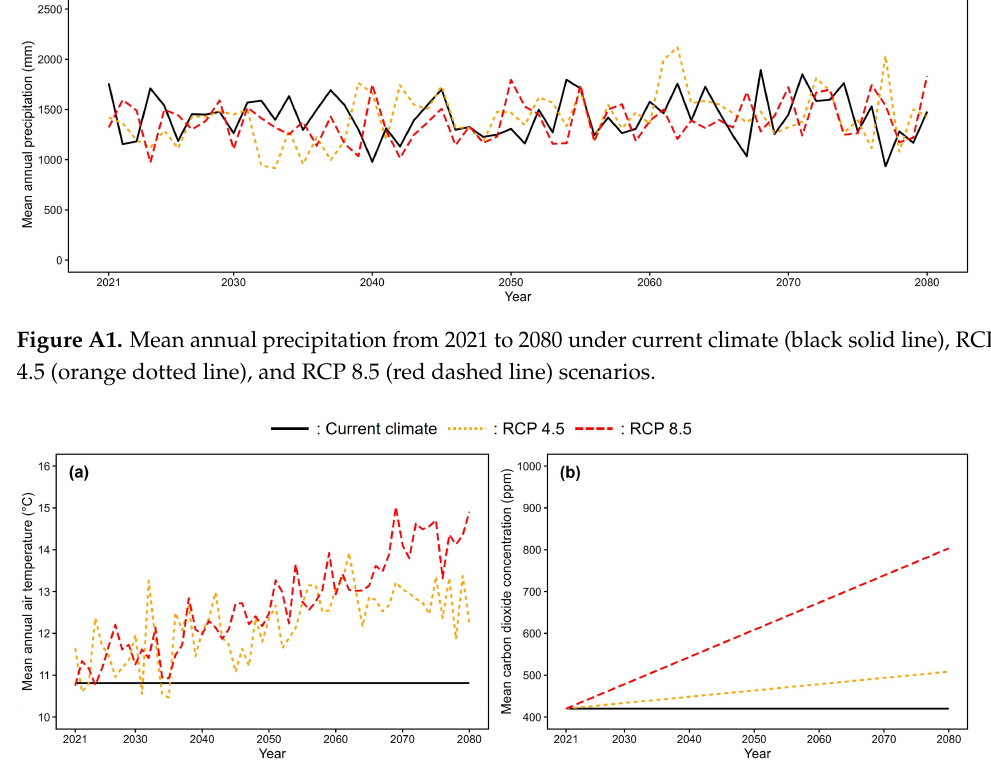
Figure A2. Mean ( a ) annual air temperature and ( b ) CO 2 concentration from 2021 to 2080 under cur- rent climate (black solid lines), RCP 4.5 (orange dotted lines), and RCP 8.5 (red dashed lines)